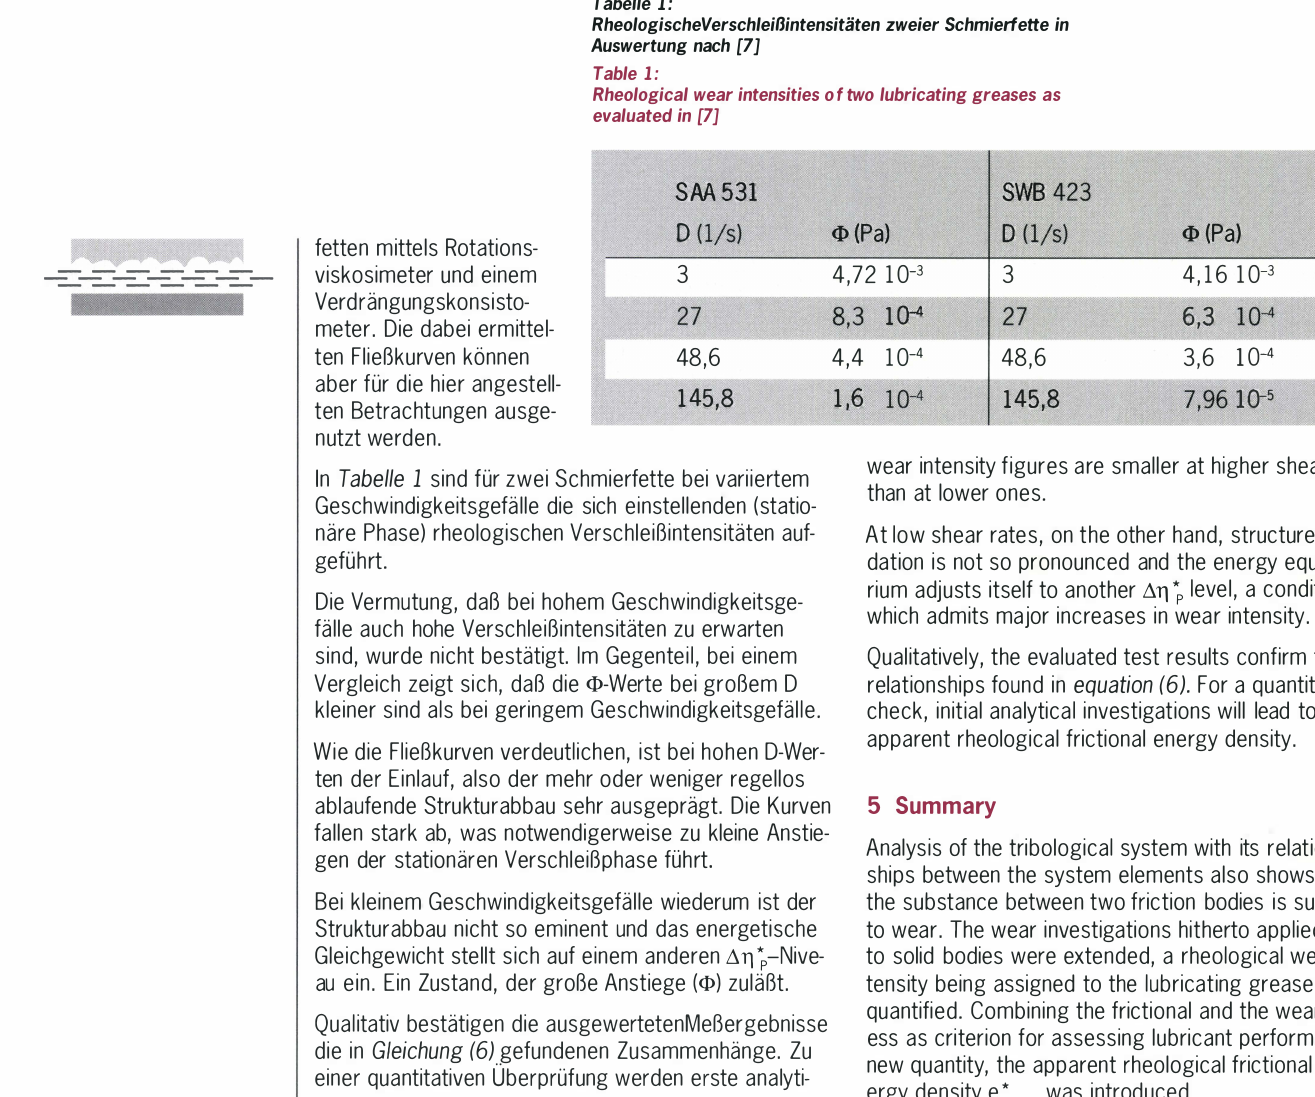
Tabe/le I: RheologischeVerschlei/Jintensitiiten zweier Schmierfette in Table I: Rheological wear intensities of two lubricating greases as evaluated in [7]